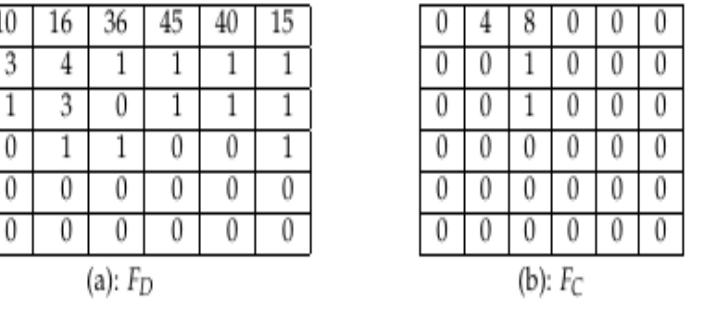
Figure 2. Regions-Of-Motion (ROM) Identification. ( a ) Difference frame: example 2-D array of pixel values ( b ) Current frame: example 2-D array of pixel values corresponding to the FD array ( c ). Extracted ROM after